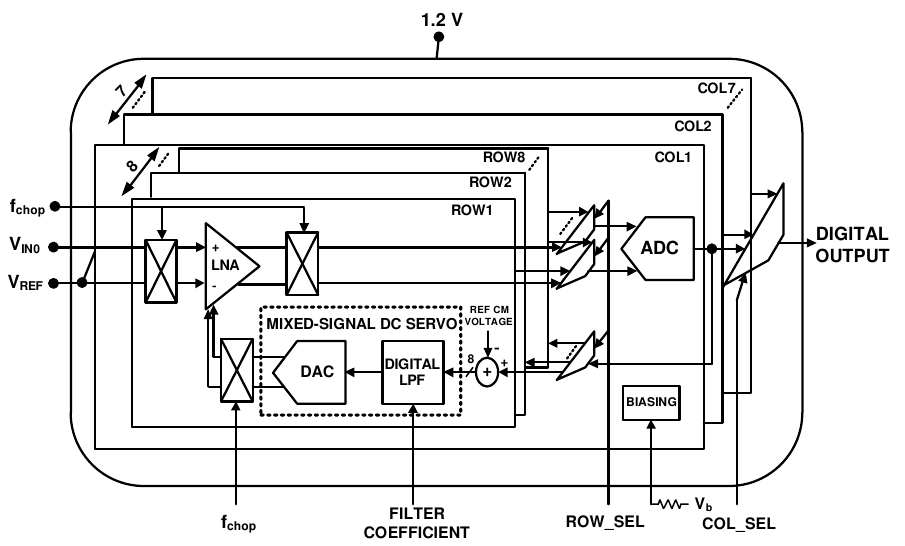
Figure 11. A block diagram of the 56-channel neural recording implant utilizing DC-coupled FEA and digital DC servo loop